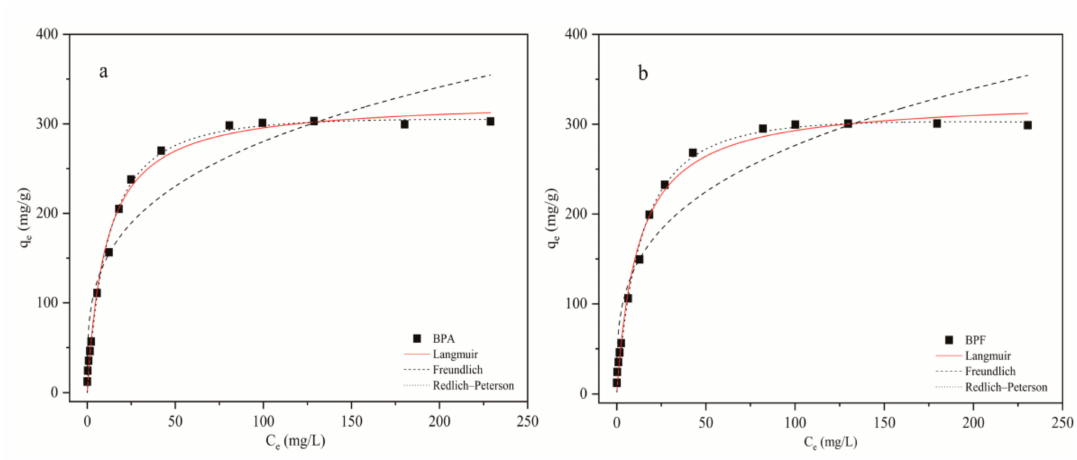
Figure 6. Adsorption isotherms obtained for BPA ( a ) and BPF ( b ) on MCGC. Table 1. Adsorption isotherm parameters obtained for bisphenol A (BPA) and bisphenol F (BPF) on